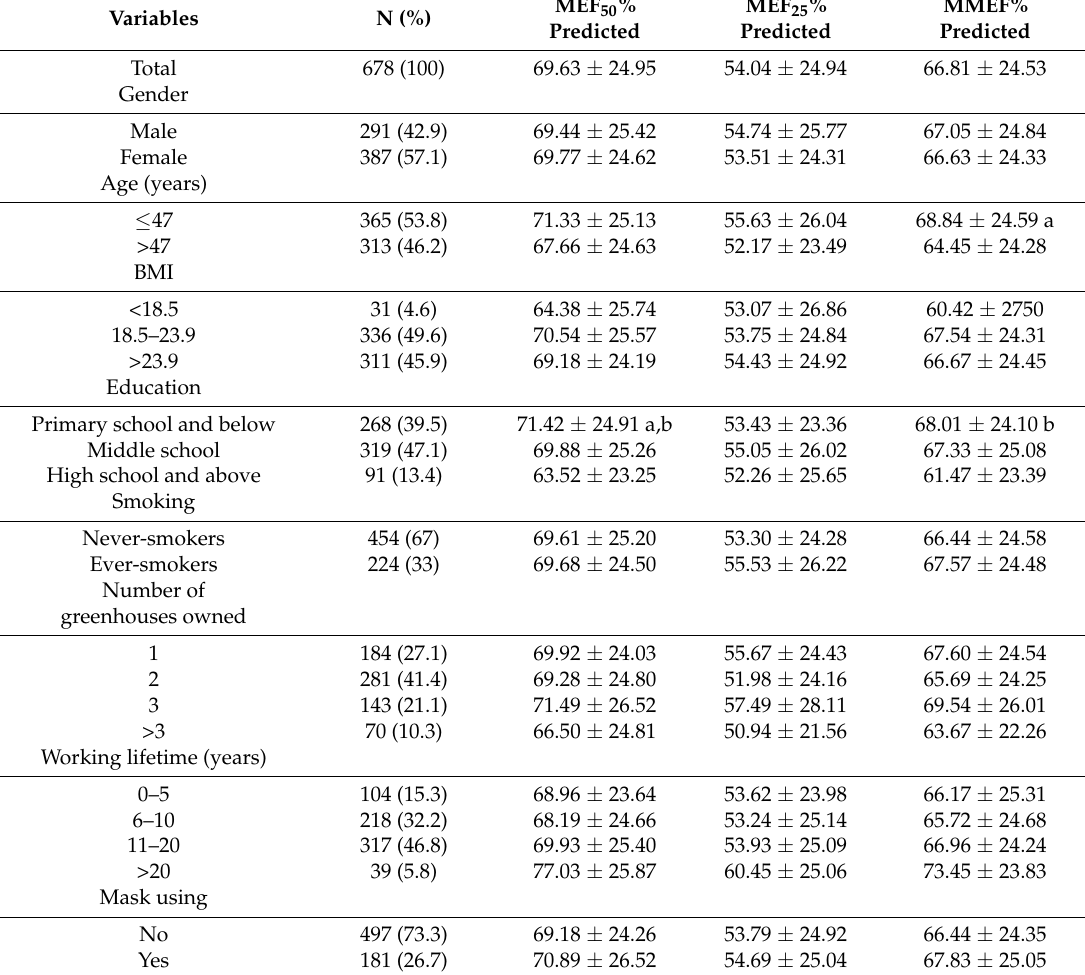
Table 4. The mean values and SDs of small airway function indicators among greenhouse